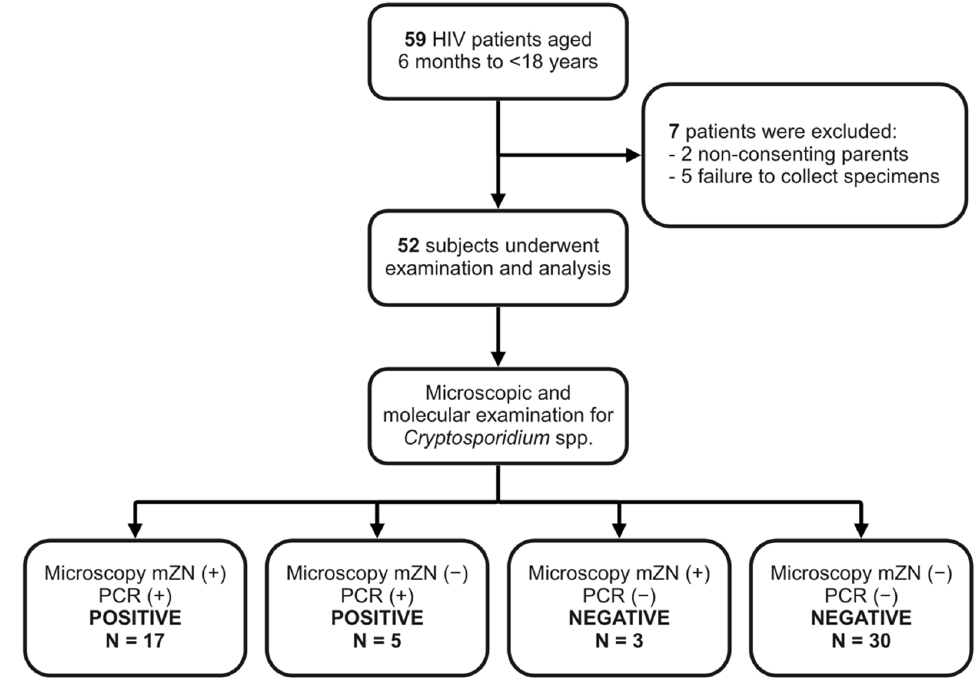
Figure 1. Study flow.